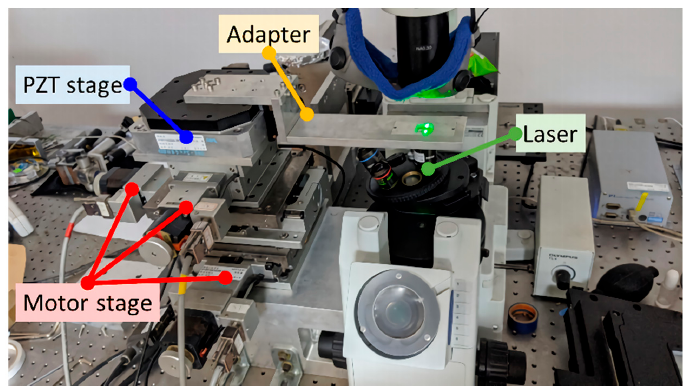
Figure 11. Integration of the combined stage and the TPP system.